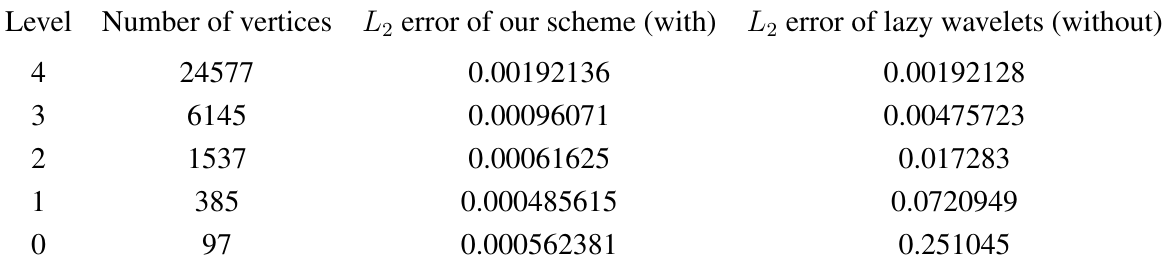
Table 3. L error of hat in different levels (with and without lifting). 2